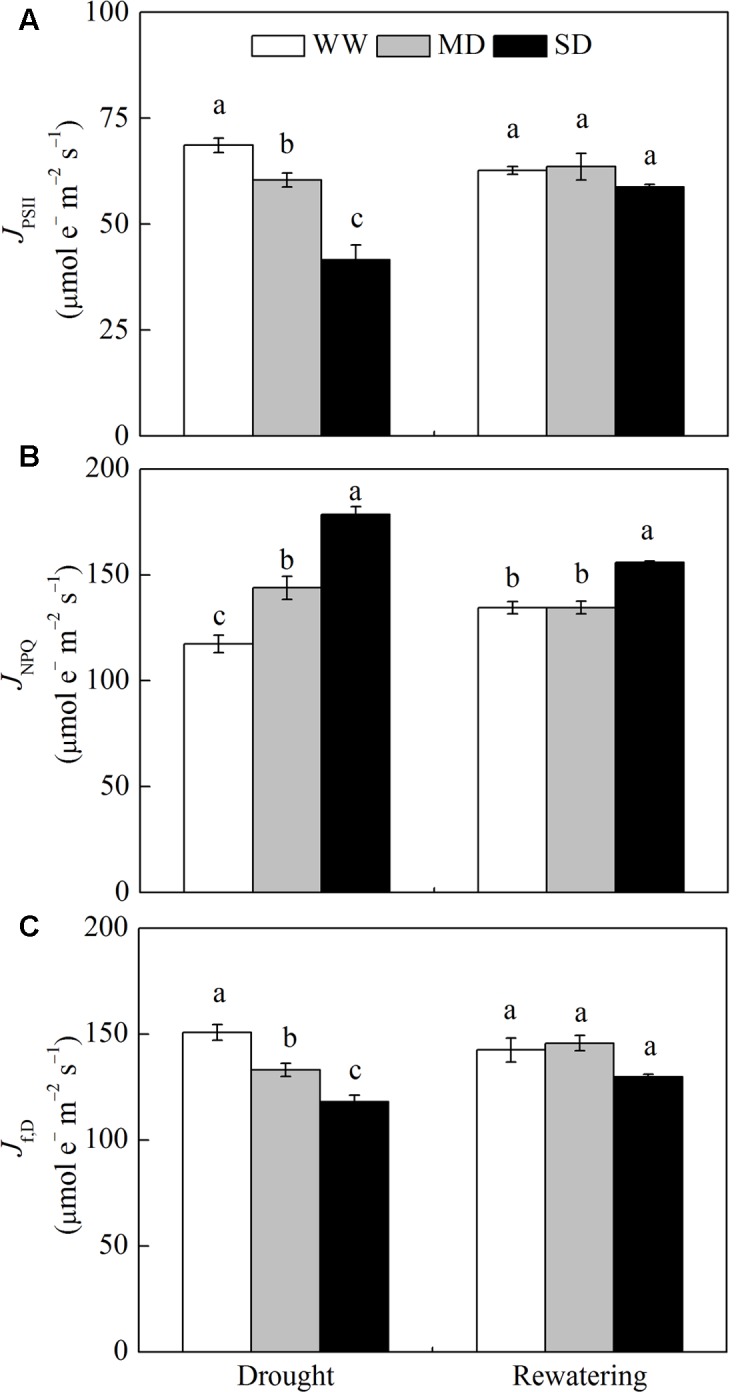
Changes in energy dissipation flux via different pathways of Fargesia rufa plants under drought and rewatering. (A) energy flux via linear electron transport in PSII (JPSII), (B) energy flux viaΔpH- and xanthophyll-mediated thermal dissipation (JNPQ), and (C) energy flux via fluorescence and constitutive thermal dissipation (Jf,D). Well-watered (WW, open bars), moderate drought (MD, gray bars), and severe drought (SD, closed bars). Data are the means of four replicates with SE shown by vertical bars. Different letters within the same stage indicate significant differences (P < 0.05) according to Duncan’s test.